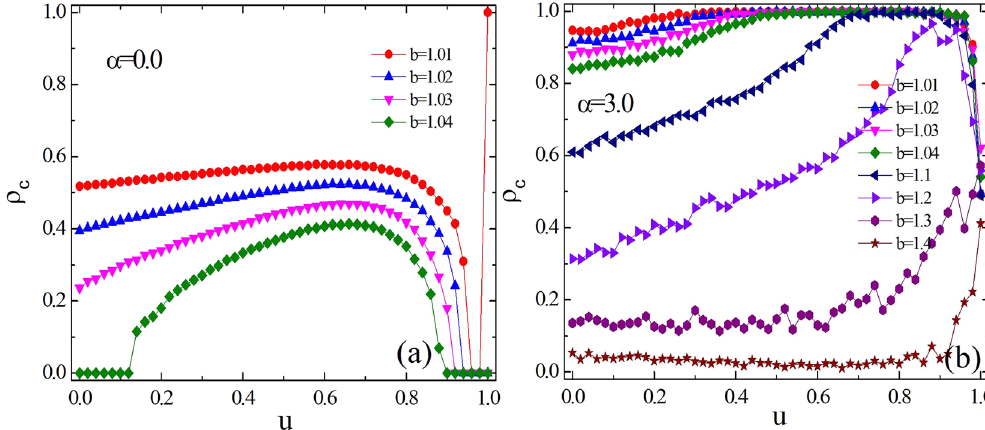
Figure 3. The fraction of cooperation ρ c versus the parameter u . Panels (a) and (b) represent the results for α = 0.0 and α = 3.0, respectively. Both panels show that cooperation is best promoted for larger u values, irrespective of which α applies. Panel (b) suggests that the parameter u can enable cooperators to reach their exclusive dominance when b is relatively small.